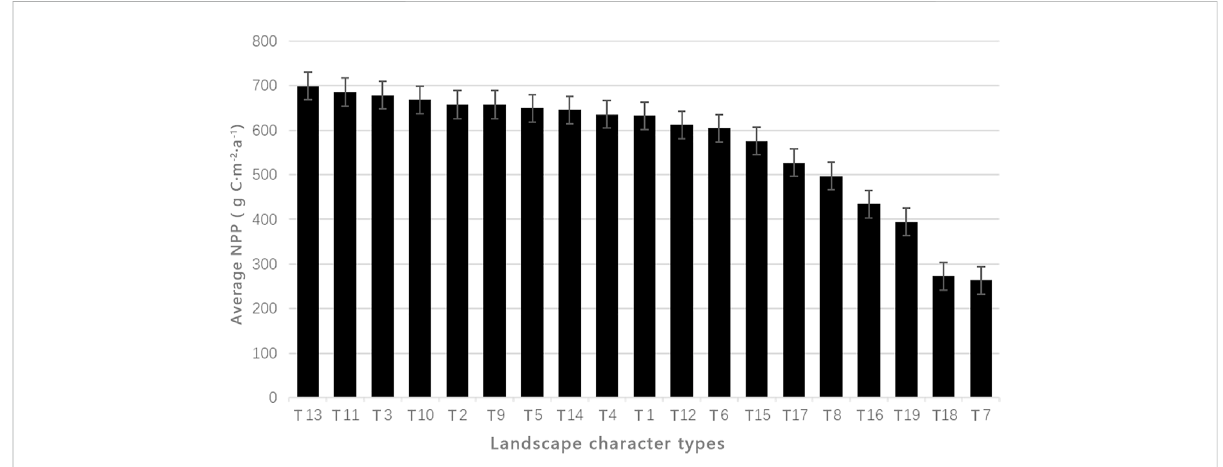
FIGURE 4 Average NPP supply capacity of different landscape character types.